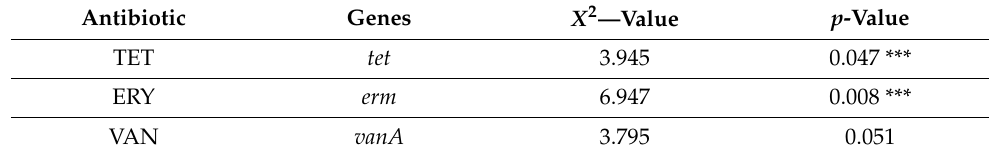
2.5. Association between Antimicrobials and Resistance Genes Differences in antimicrobial resistance patterns and resistance genes in both enterococ- cus species were analyzed to assess possible associations between resistance phenotypes and their corresponding genotypes. A positive association between phenotype and geno- type was found for tetracycline ( p = 0.047) and erythromycin ( p = 0.008), but there was no association between genotype and the vancomycin resistance phenotype ( p = 0.051)